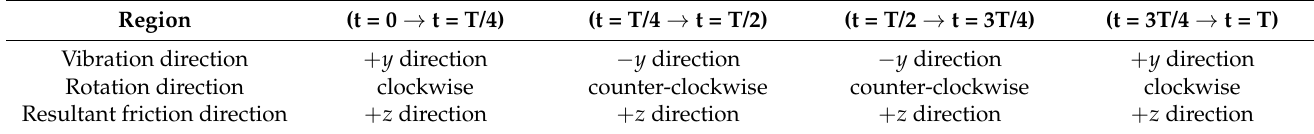
Table 3. The direction of vibration and rotation.